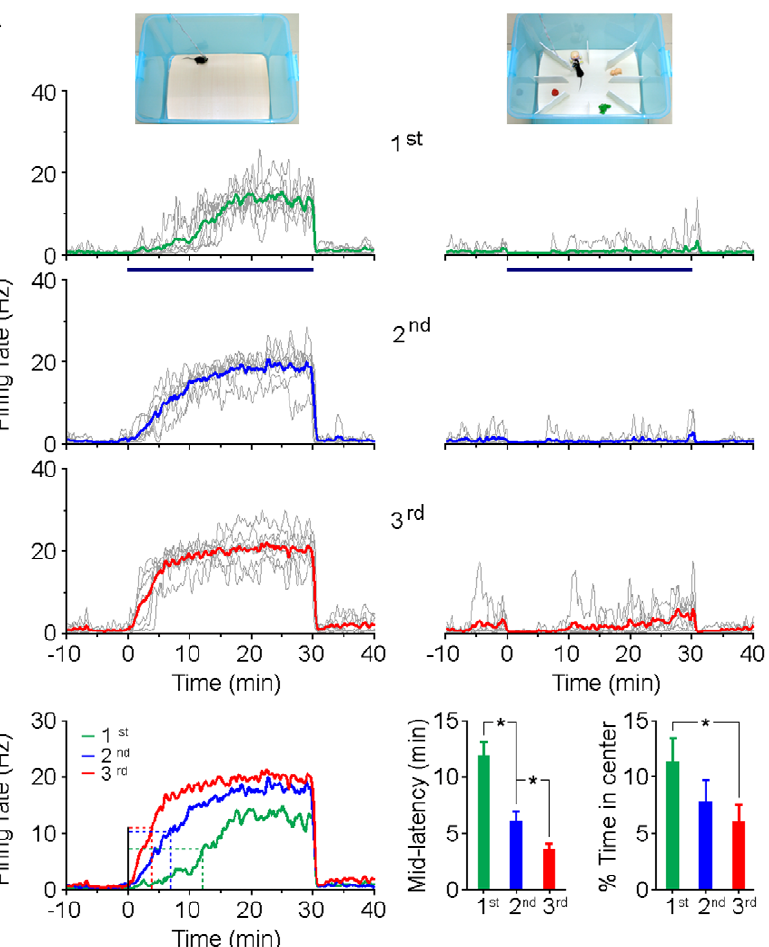
Figure 5. Activation of type-1 BLA neurons correlates with levels of anxiety. (A) Rate histograms of type-1 BLA neurons (n=7) during repeated exposure to an open field (left panels) and an enriched box (right panels). Green, blue and red lines represent average responses while grey lines for each individual neuron. Horizontal lines below the histograms indicate the exposure duration (30 min). (B) Left panel, average rate histograms show increased activity of type-1 BLA neurons in repeated open field tests. Horizontal dotted line marked the half maximum firing rates of type-1 neurons; vertical dotted line marked the latencies of half maximum firing rates. Middle and right panels, mid-latencies of maximum firing rate of type-1 neurons (n=7; mean 6 SEM) and time spent in the center of the open field (n=10; mean 6 SEM) in repeated open-field tests. * P , 0.05 by t - test.